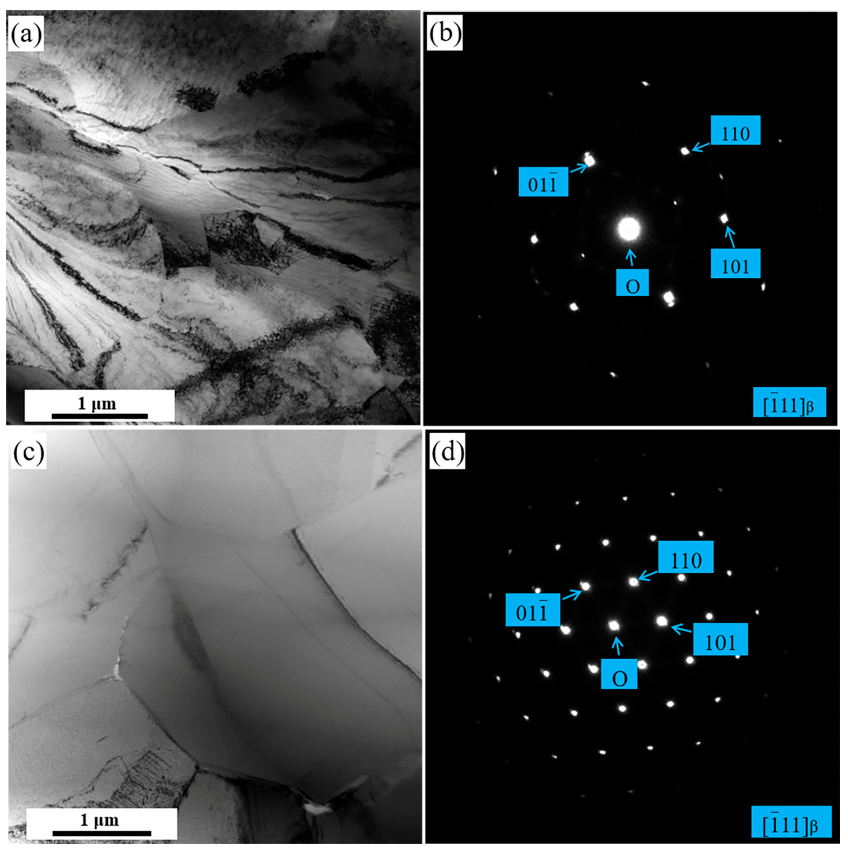
Figure 10. TEM micrographs of Ti555211 alloy compressed at 950 °C and 1050 °C and at a strain rate of 5 s − 1 : ( a ) Bright field image at 950 °C; ( b ) Selected area diffraction pattern in ( a ) at 950 °C; ( c ) Bright field image at 1050 °C; ( d ) Selected area diffraction pattern in ( c ) at 1050 °C.